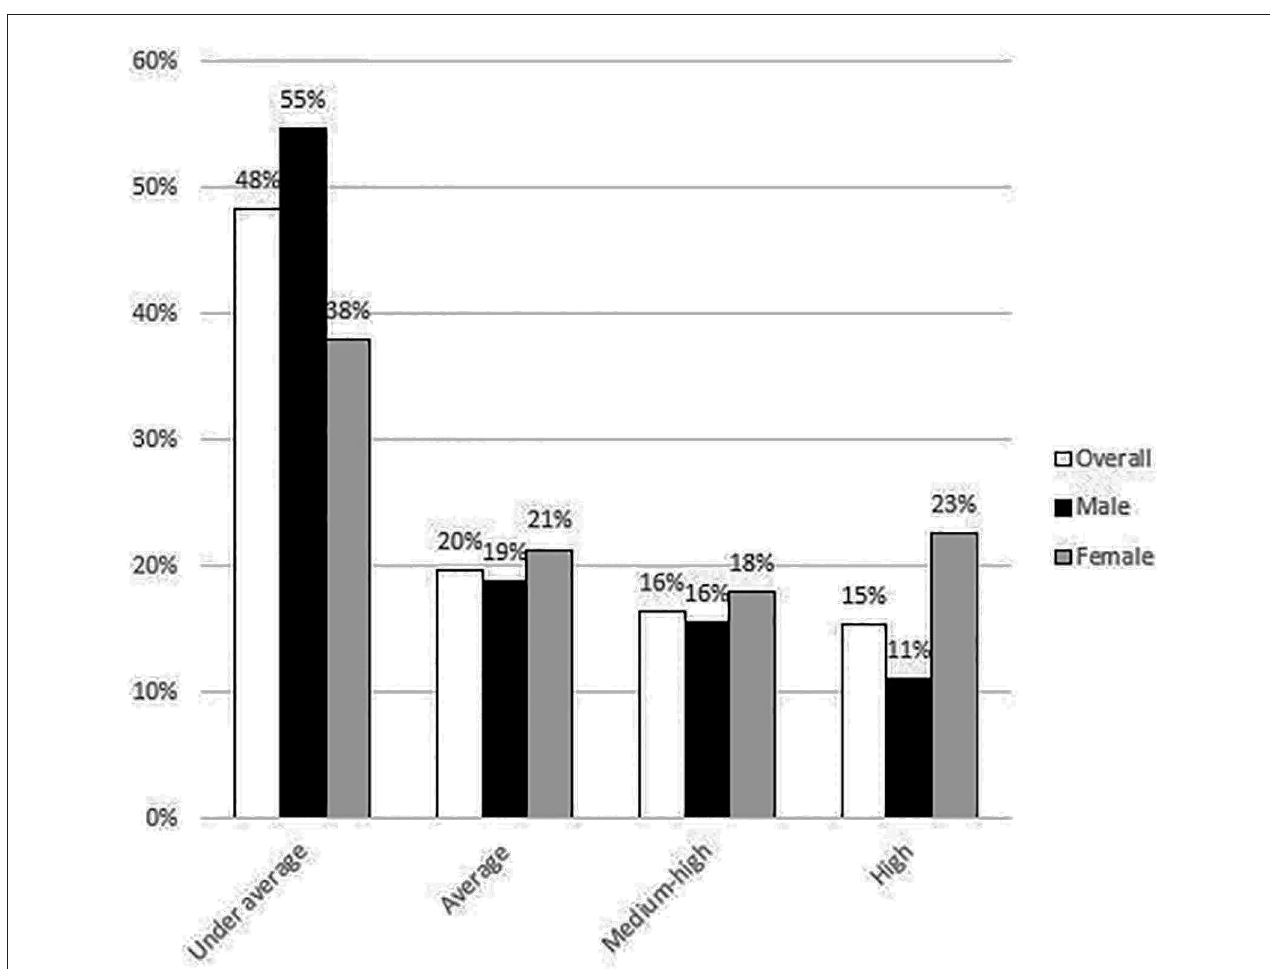
FIGURE 1 | Sample distribution according to gender in the perceived stress scale categories.